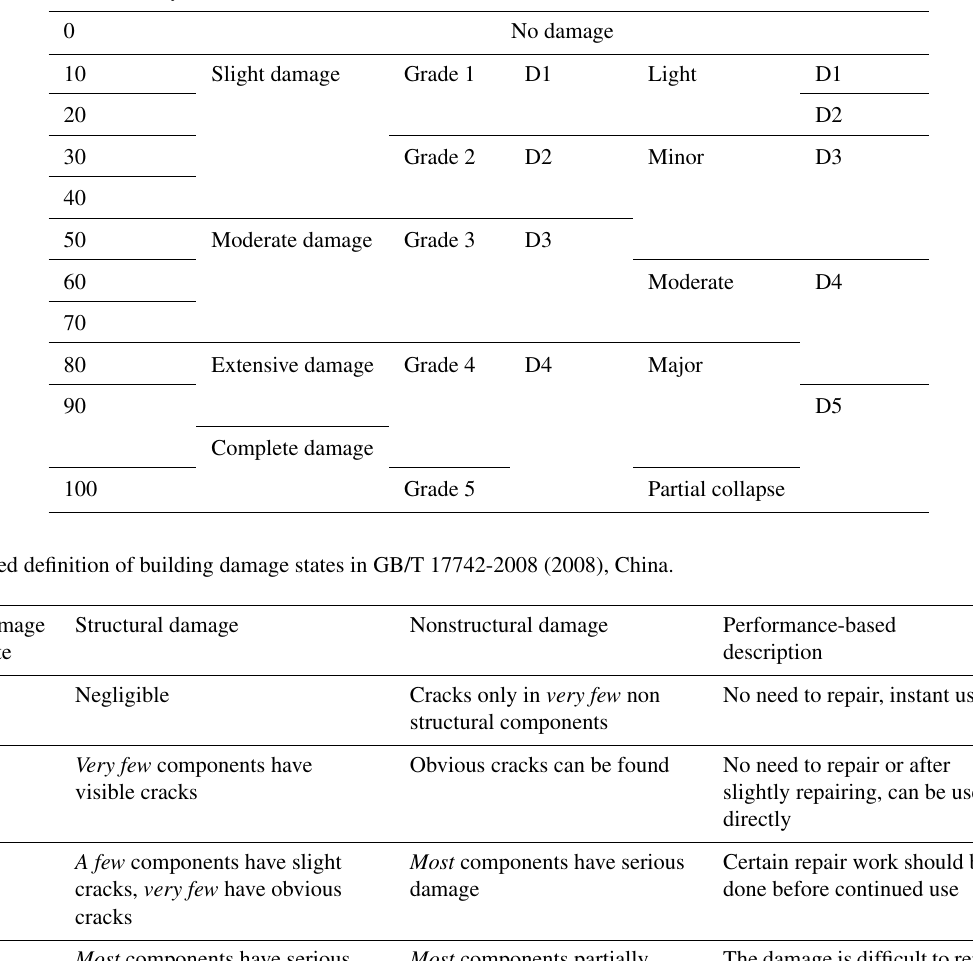
Most components partially